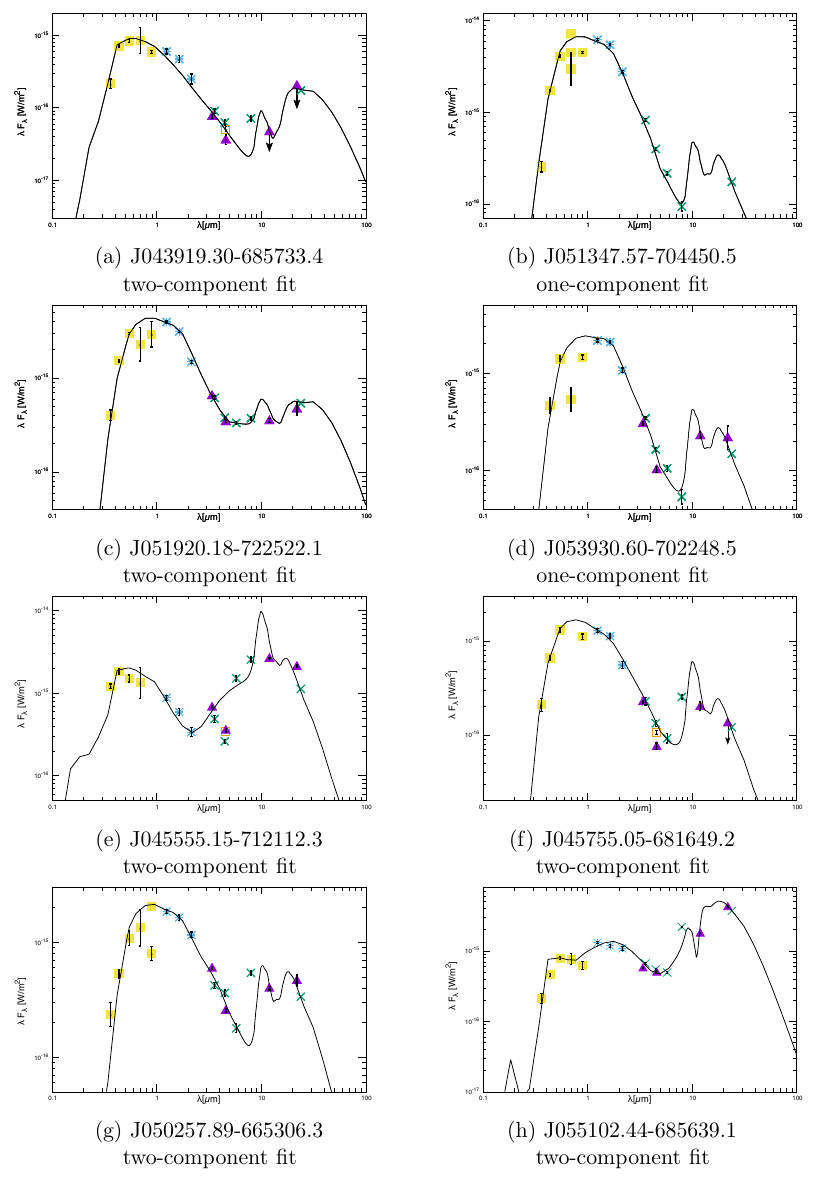
Figure 2. The best–fit models (black curves) to the observed SEDs of the post-RGB sources. The observed fluxes are de-reddened for Galactic and LMC reddening. U, B, V, R, I (yellow), 2MASS J, H and K (cyan) data are plotted along with WISE (purple) and ALLWISE (orange) photometry nd data from the SAGE-LMC Survey (green), which covers the IRAC and MIPS bands. The error bars and upper limits (arrows) are indicated in